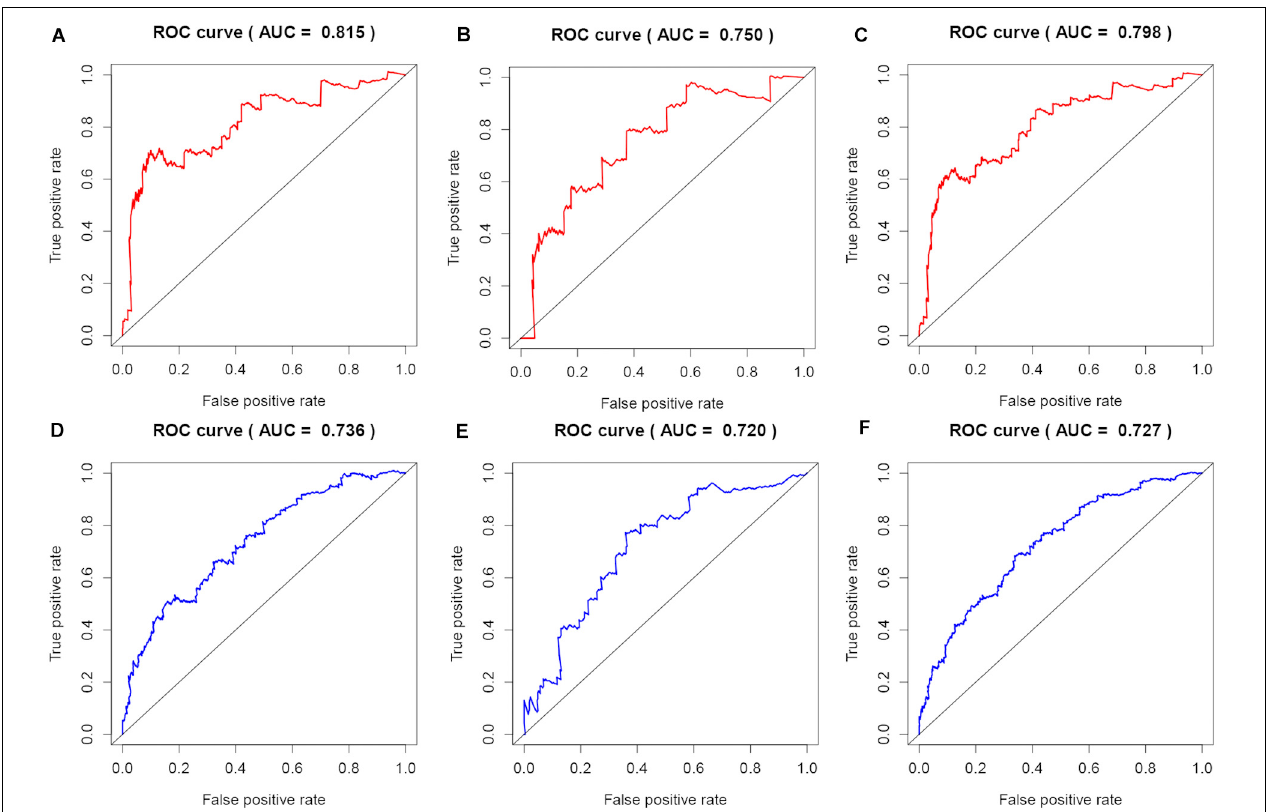
FIGURE 6 | Evaluation of predicting prognostic ability for models. (A–C) Time-dependent ROC curves of the signature at 5 years for OS in the training, test, and whole sets. (D–F) Time-dependent ROC curves of the signature at 5 years for RFS in the training, test, and whole sets.